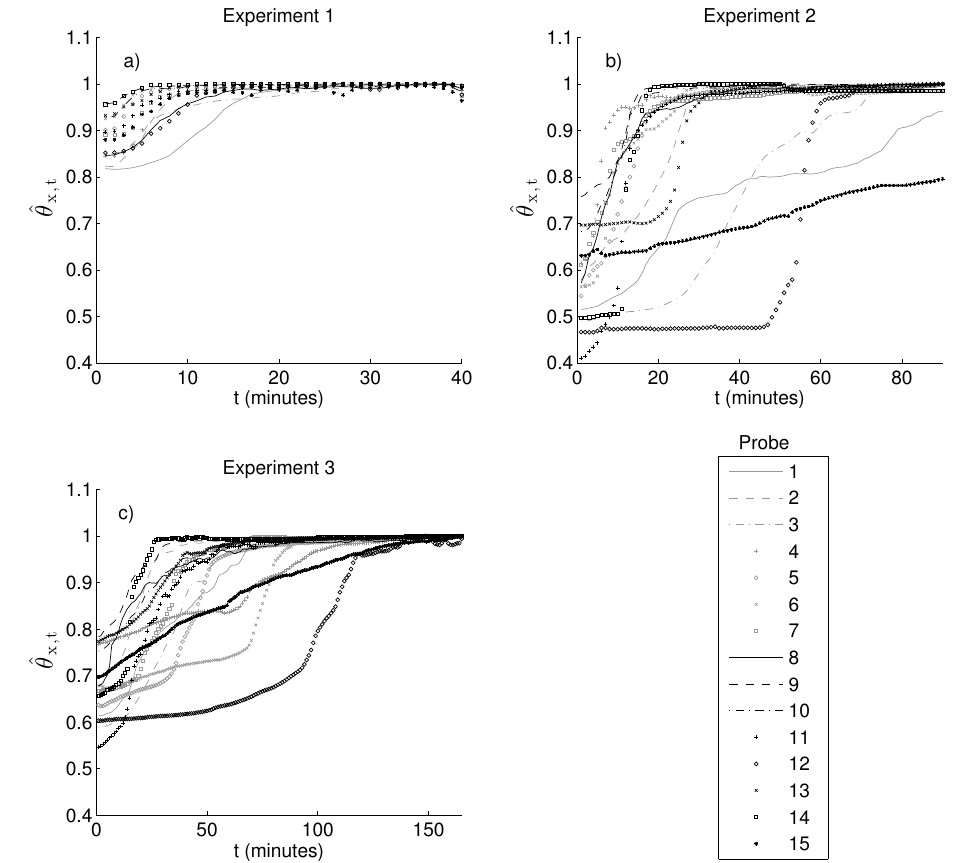
Figure 8. Soil moisture as ˆ θ x,t for each TDR probe. (a) Experiment 1. The soil started near saturation due to previous test runs. (b) Experiment 2. (c) Experiment 3.